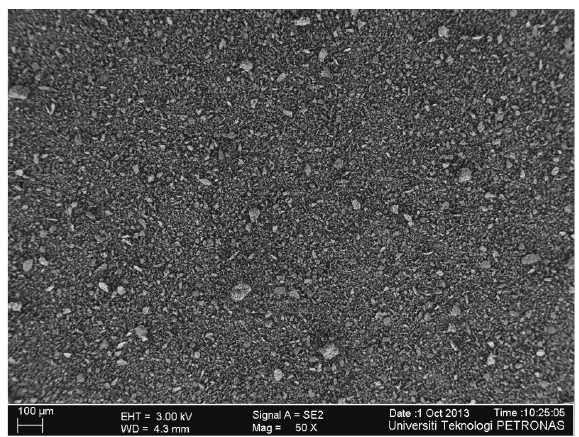
Figure 4: Microstructure of metakaolin through field emission scanning electron microscope (FESEM) showing particle size dis- tribution.